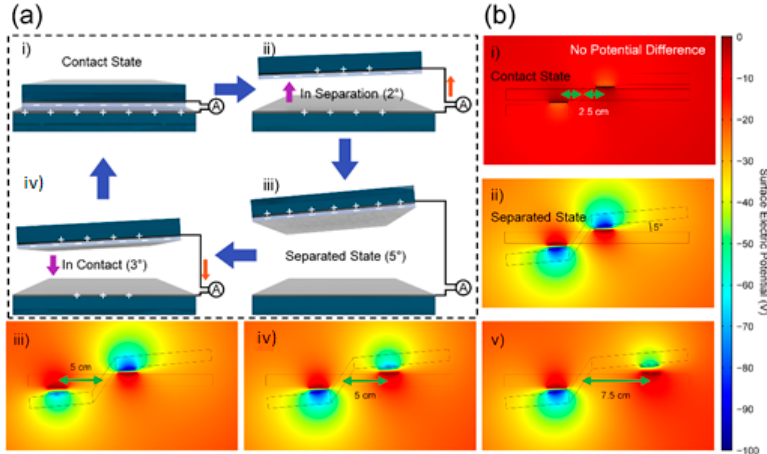
Figure 2. ( a ) Operation principle of the L-TENG. ( b ) FEM simulation results presenting the electric potential with different distance